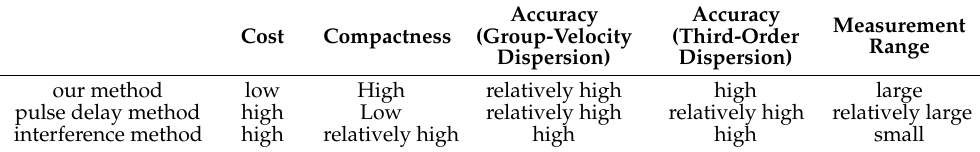
Table 2. Comparison between our method and some conventional